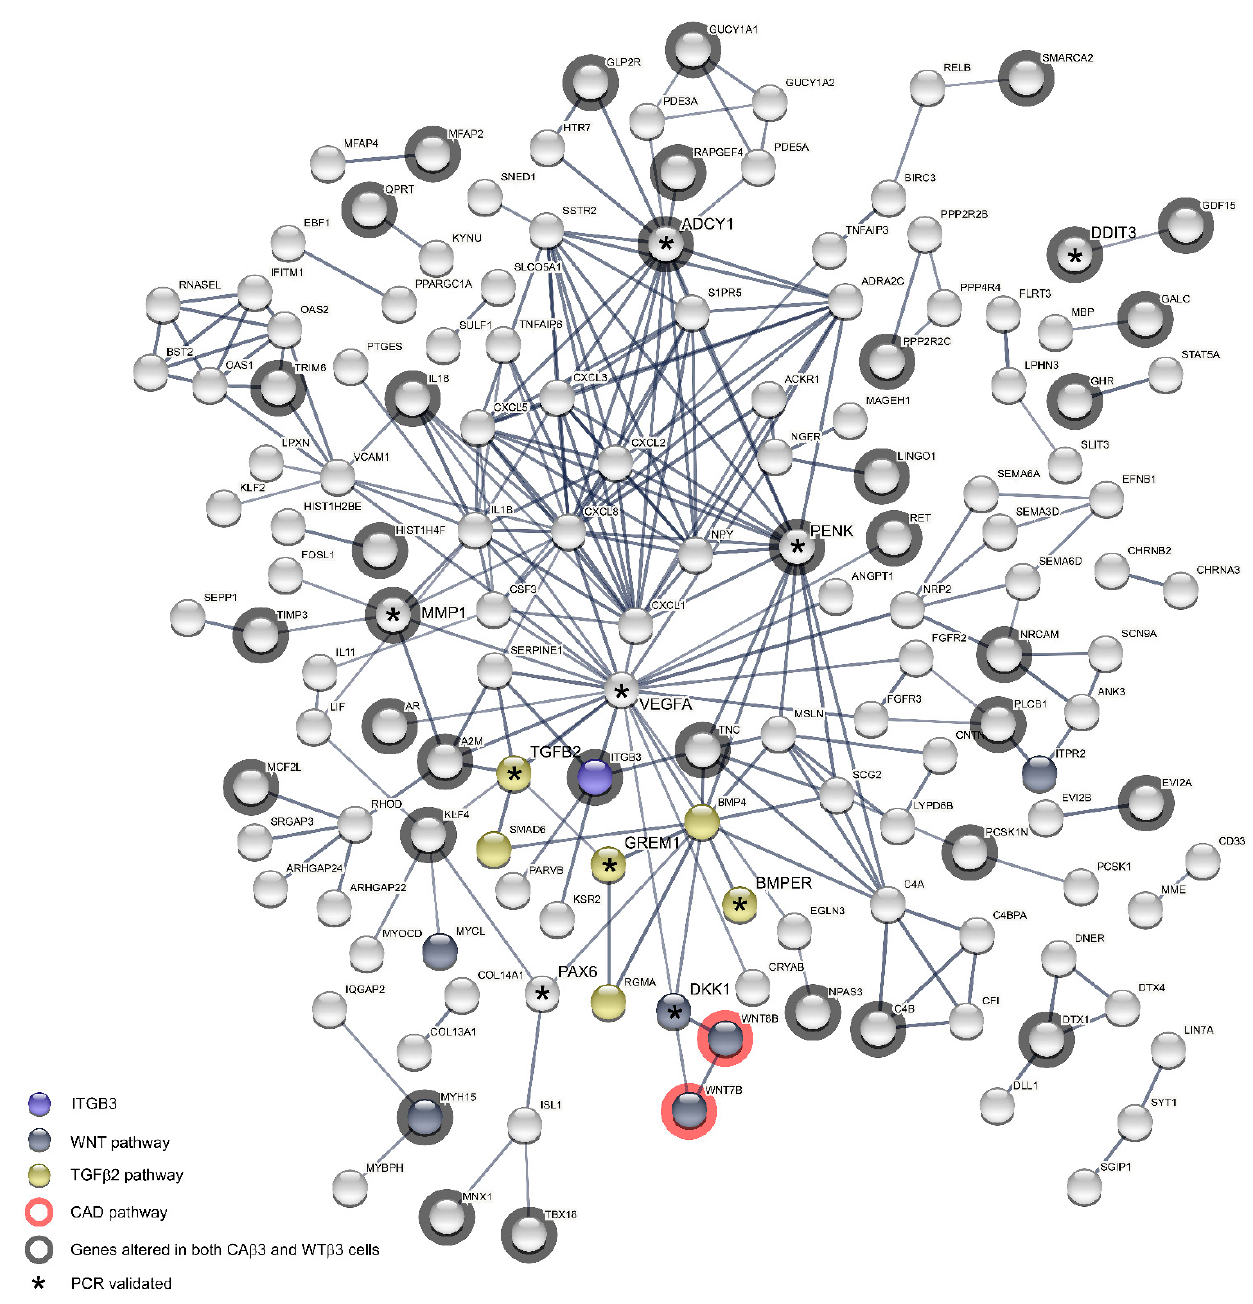
Figure 14. High confidence CA β 3 PPI network shows an extensive network of potential interactions. Differentially expressed genes resulting from overexpression of a CA- α v β 3 integrin were entered into the STRING database. The input consisted of uniquely altered genes as well as altered genes that were shared with cells overexpressing a WT- α v β 3 integrin. The calculated network (statistical confidence = 0.7) has a PPI enrichment value = 1 × 10 − 16 indicating that the network has significantly more interactions than expected for a random collection of input genes at the same confidence level. The location of β 3 integrin (INTB3), members of the TGF β 2, Wnt and Cadherin (CAD) signaling pathways as well as those gene products that are also differentially expressed in WT β 3 cells are all indicated. * Genes that were validated by RT-qPCR. The proteins for which there were no connections to be mapped where not displayed. (Interactive link for Figure 14: permanent link: https://version-11-0b.string-db.org/cgi/network?networkId=bZECX4AuPQ32) (accessed on 20 June 2021).